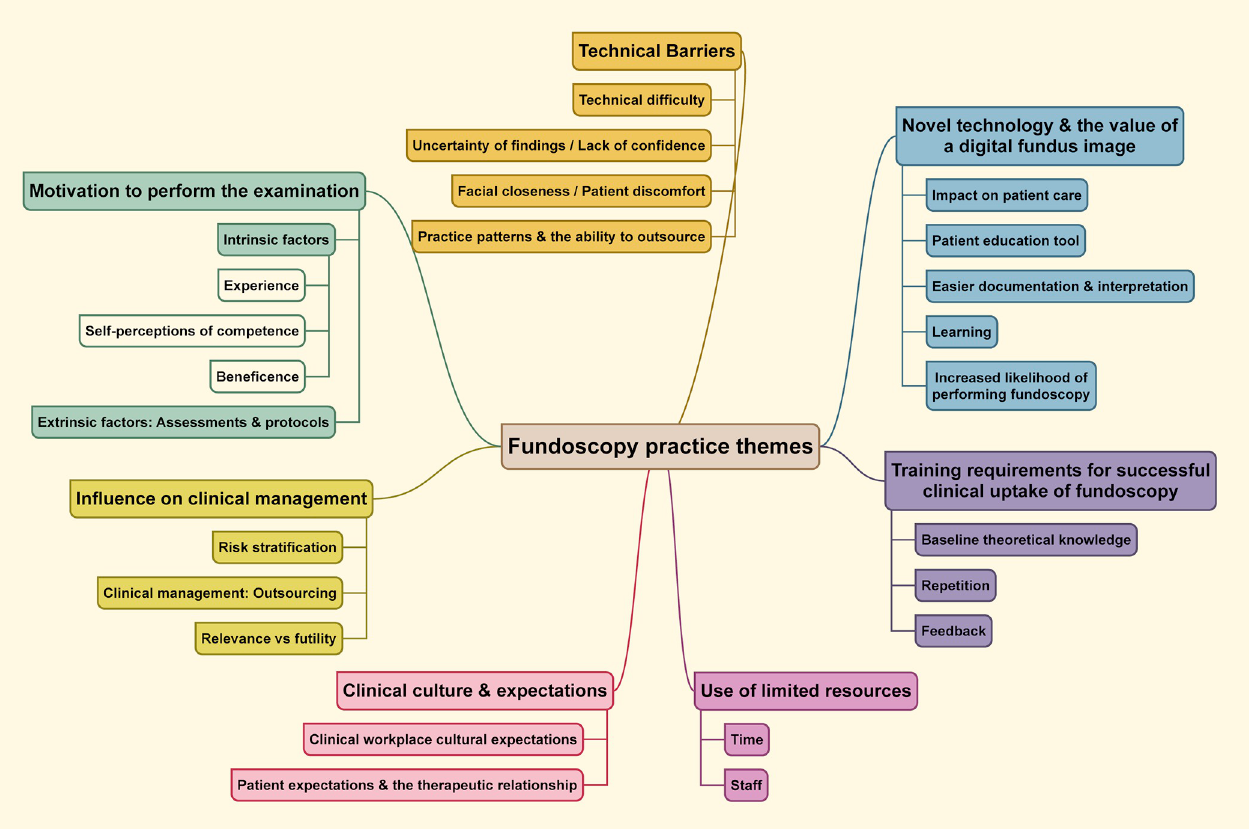
Fig 1. Themes arising from the focus groups regarding the barriers and facilitators of performing fundoscopy.